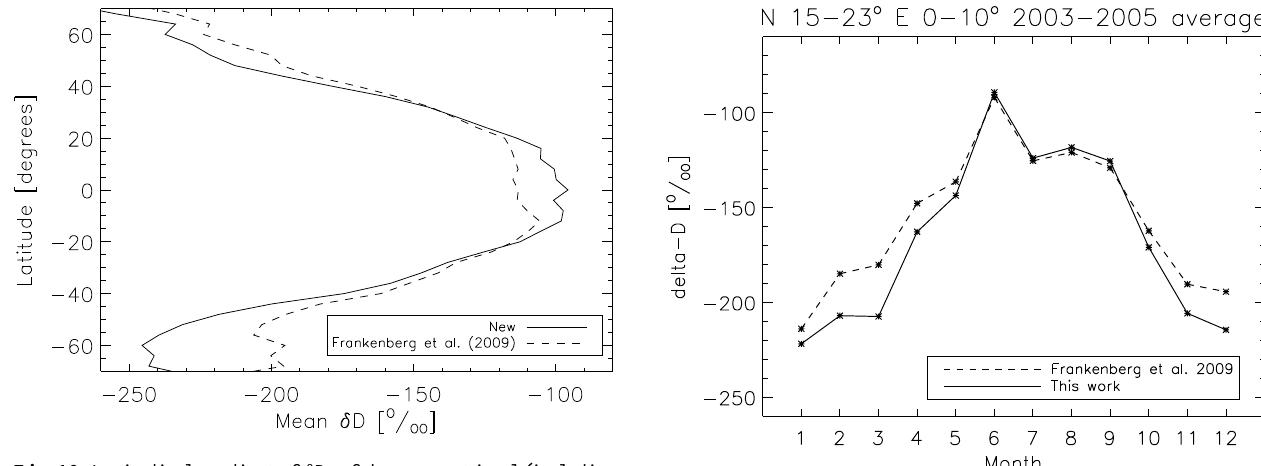
Fig. 10. Latitudinal gradient of δ D of the new retrieval (including spectroscopic updates and new calibration software) compared to the results from Frankenberg et al. (2009).